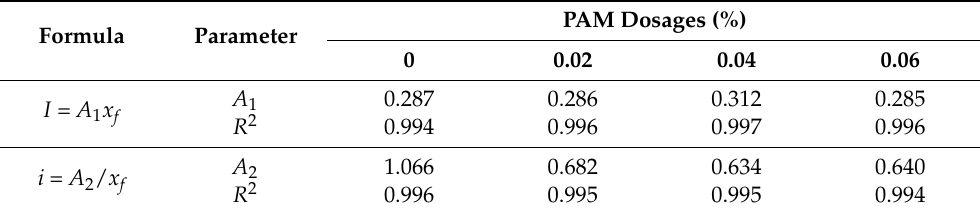
Table 3. Fitting results of the coefficients A 1 and A 2 .